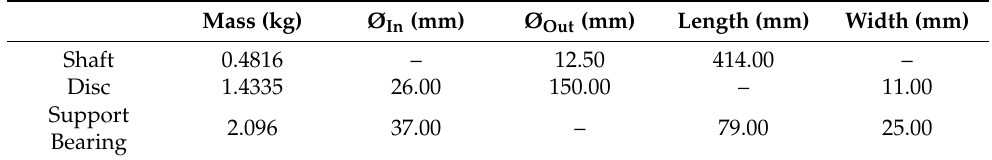
Table 2. Experimental bench parameters.